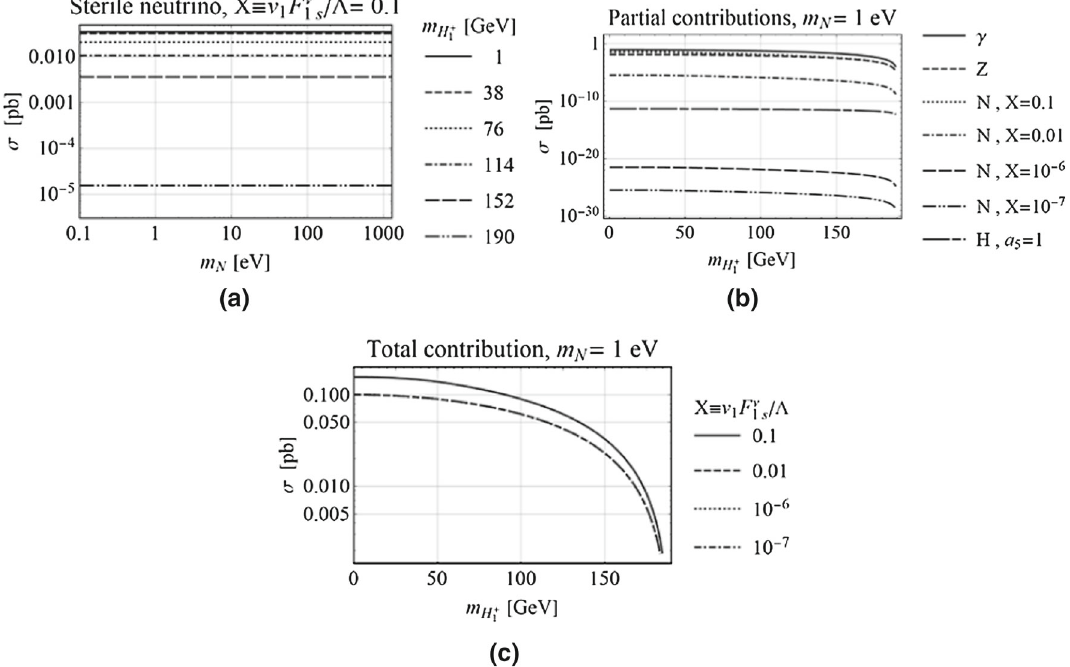
√ H − s = scalar. b The partial contribution to the cross section as a function of cross section with 1 1 the charged scalar mass. c The total cross section as a function of the charged scalar mass